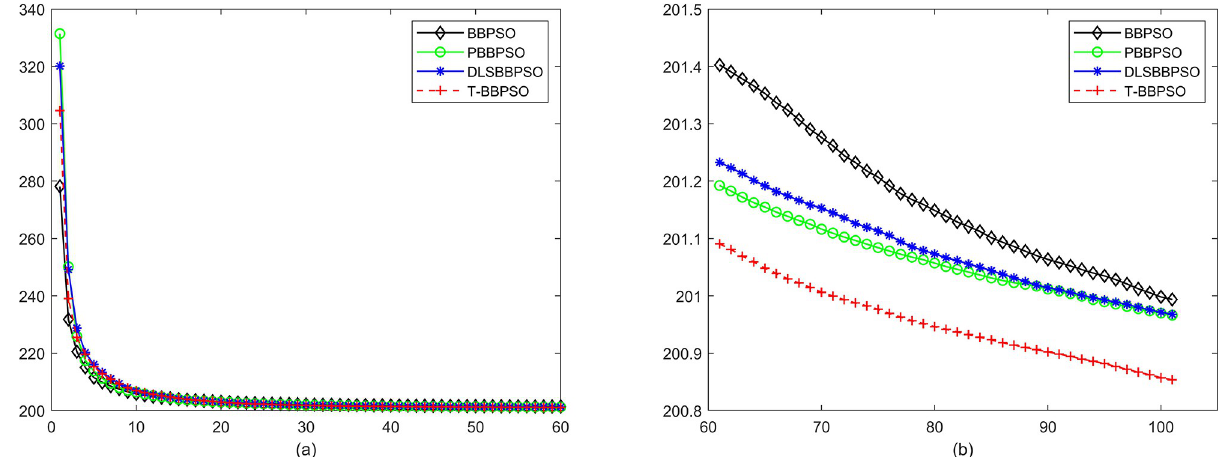
Fig 27. Comparison of convergence speed between BBPSO, PBBPSO, DLS-BBPSO and TBBPSO, f 25 , (a) iteration 0–6000, (b) iteration 6000–10000 the unit is 100 iteration.